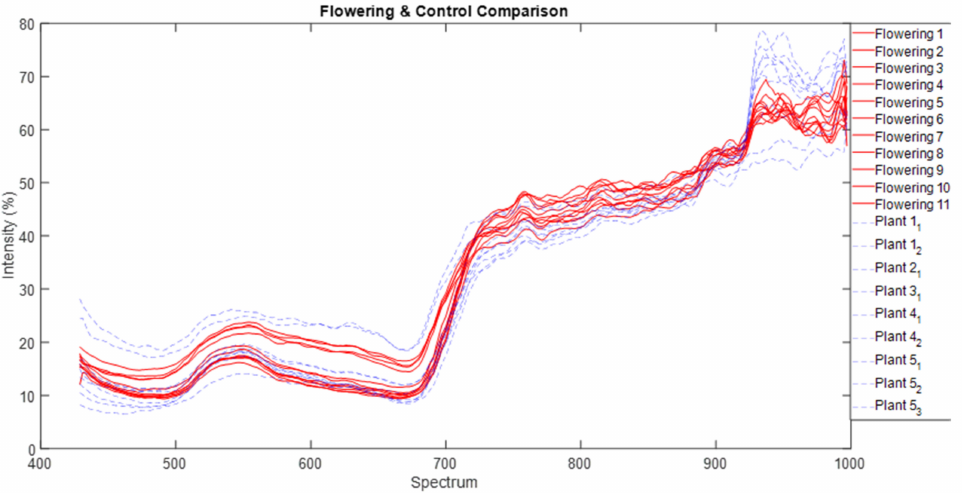
Figure 16. Spectral signature of the flowering adult stage of parthenium weed compared to the non-parthenium/control plants (Plant 1–Plant